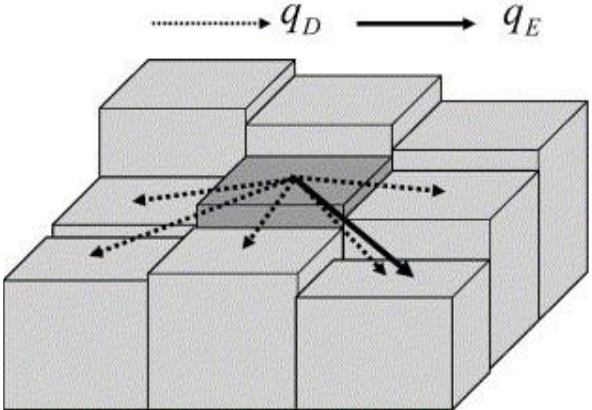
Figure 2. The local cellular model for simulating diffusive transport ( q D), and water erosion( q E). q D and q E are the volume of material that flows across an area per unit time by diffusive transport (m yr − 1 ) or water erosion (m yr − 1 ).